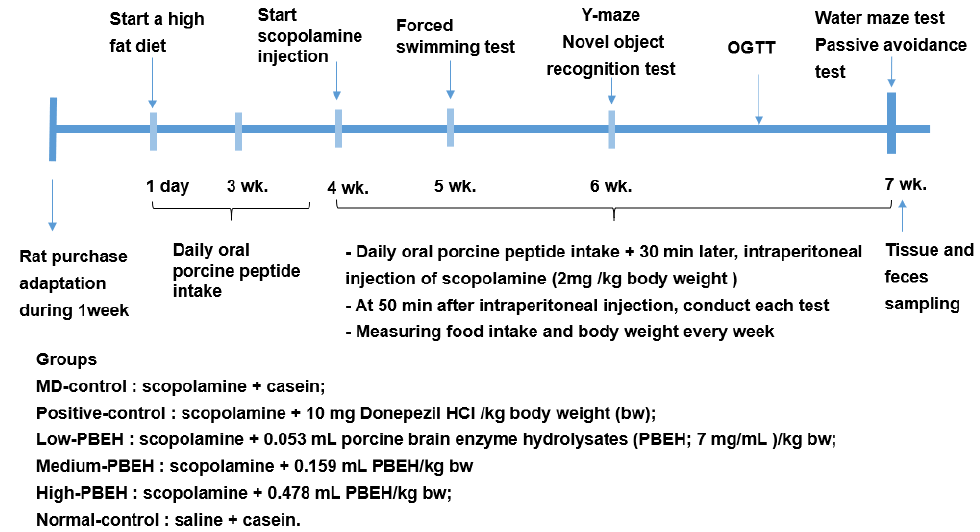
Figure 6. Experimental